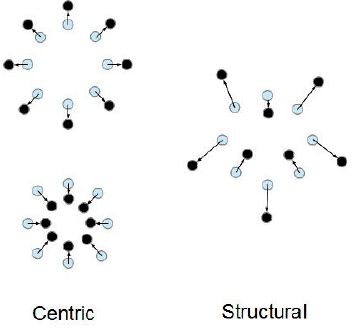
Figure 1. Centric and structural components of specific volume change.